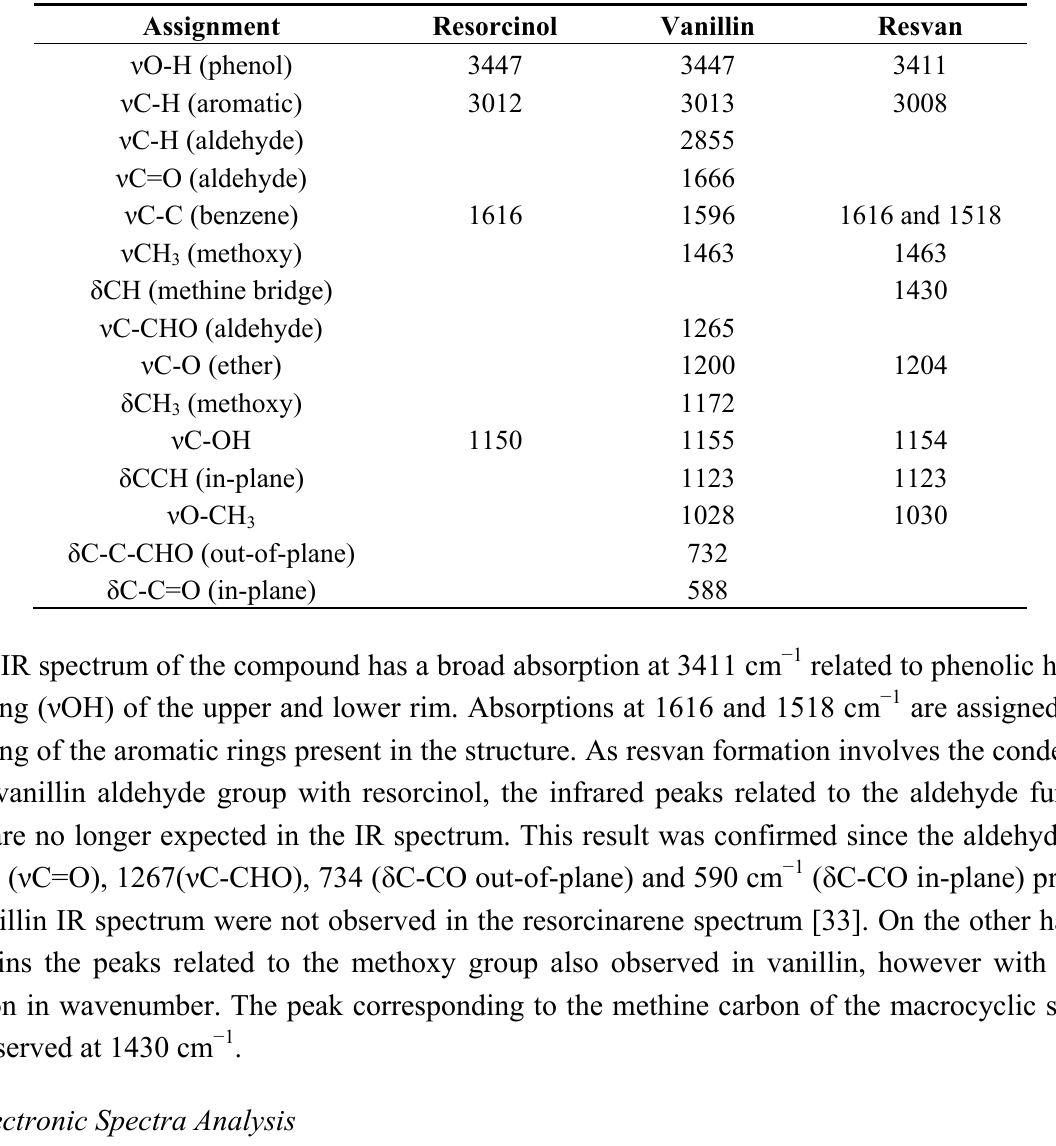
Table 1. Infrared spectra and assignments of the main bands (cm − 1 ) of the compounds resorcinol, vanillin and